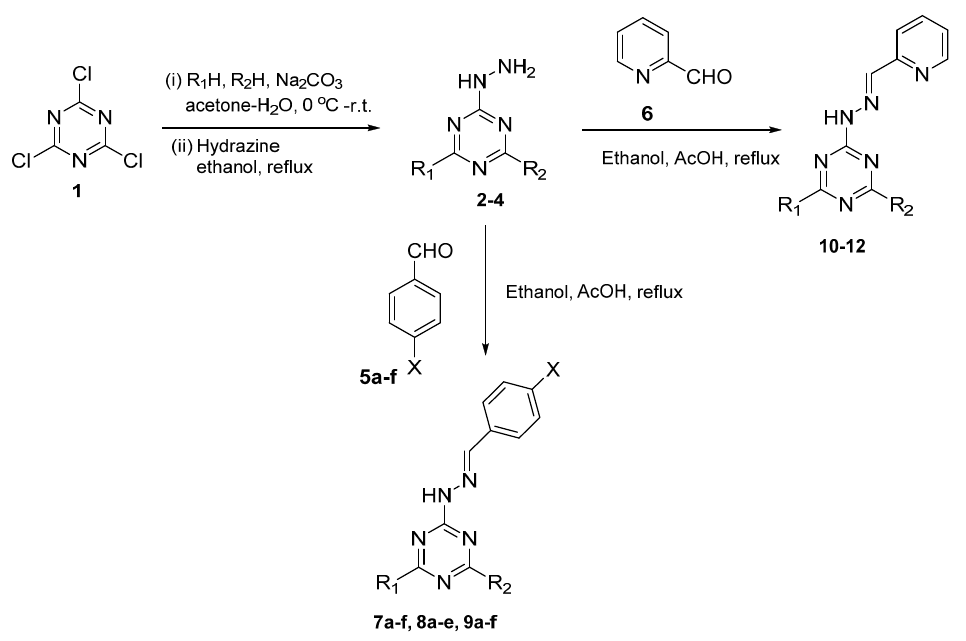
Scheme 1. Synthetic route for preparation of the target